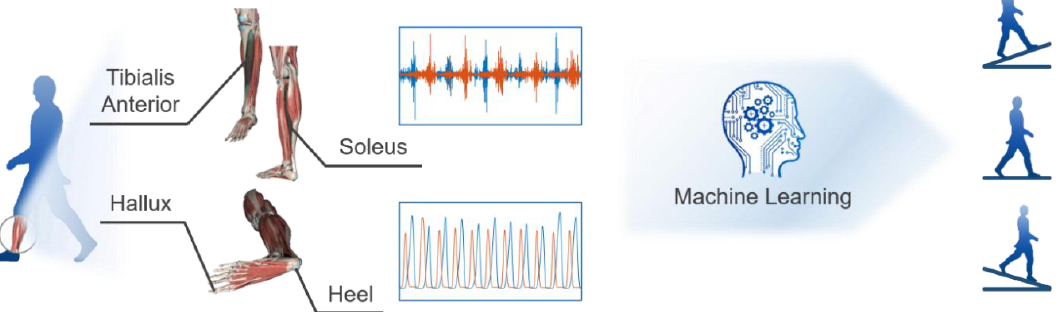
Figure 2. An overview of combining the EMG and GRF signals to identify the three different